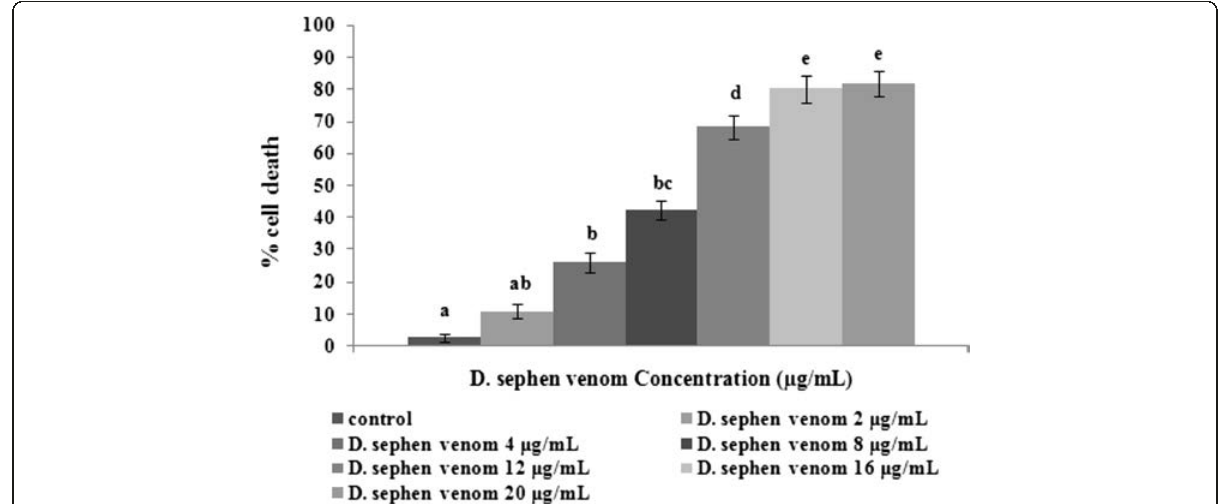
Fig. 1 Cytotoxicity of D. sephen venom on HeLa cells. The venom was incubated with cancer cells for 24 h and cytotoxicity was observed by MTT assay. Cell death was observed in a concentration-dependent manner (2 – 20 μ g/mL) in HeLa cells. Values were given as mean±SD of six experiments in each group. Values not sharing the same letter differ significantly ( p <0.05) from control